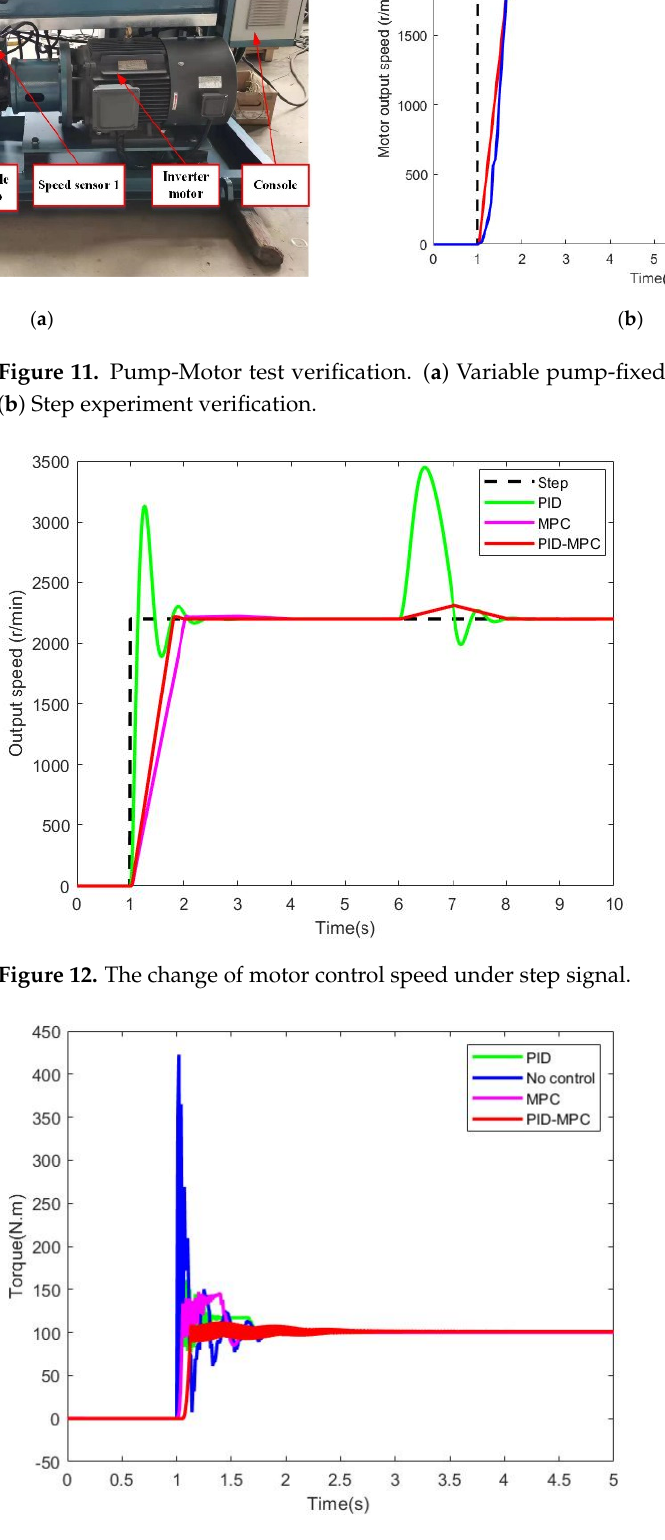
Figure 13. Variation diagram of motor control torque under step signal.